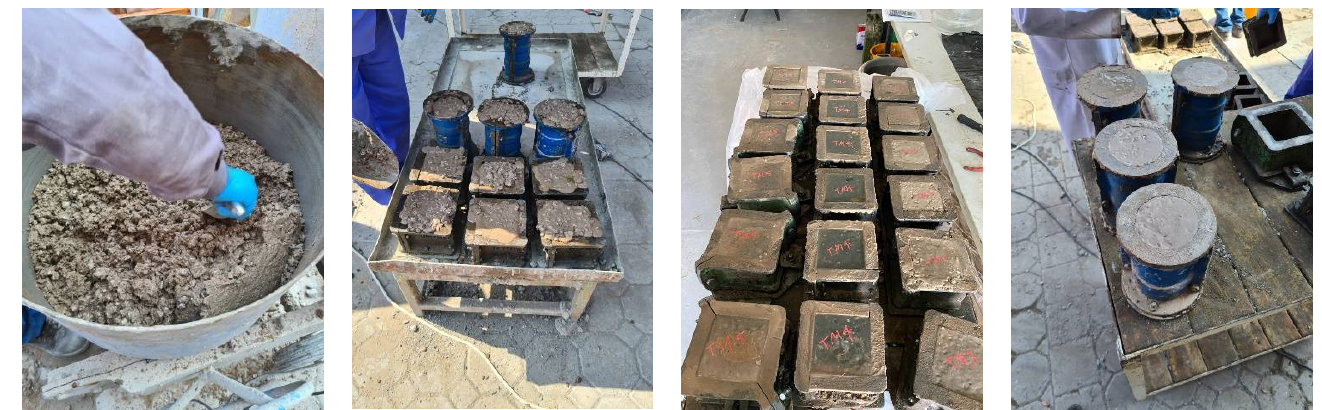
Figure 6. Casting of geopolymer concrete samples.